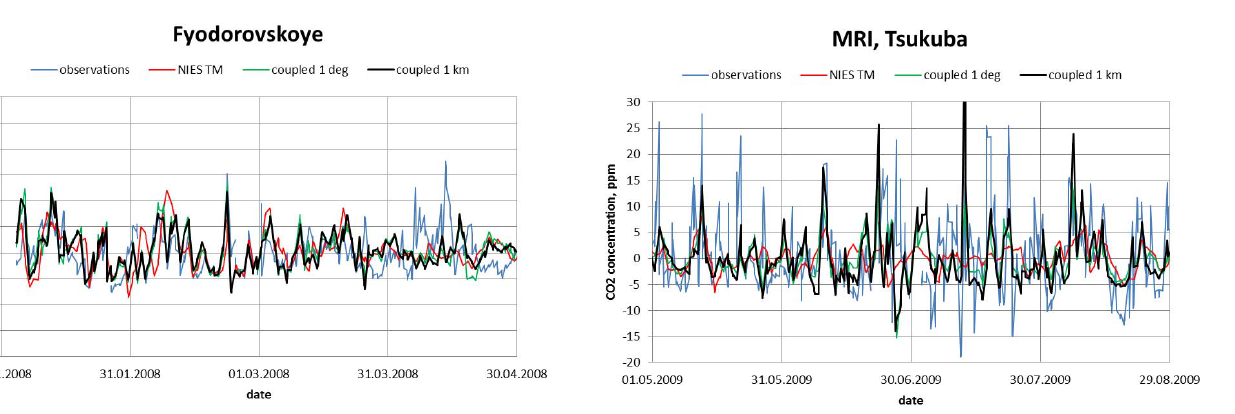
Fig. 4. Deseasonalized results for MRI tower (representative 4- month time series).